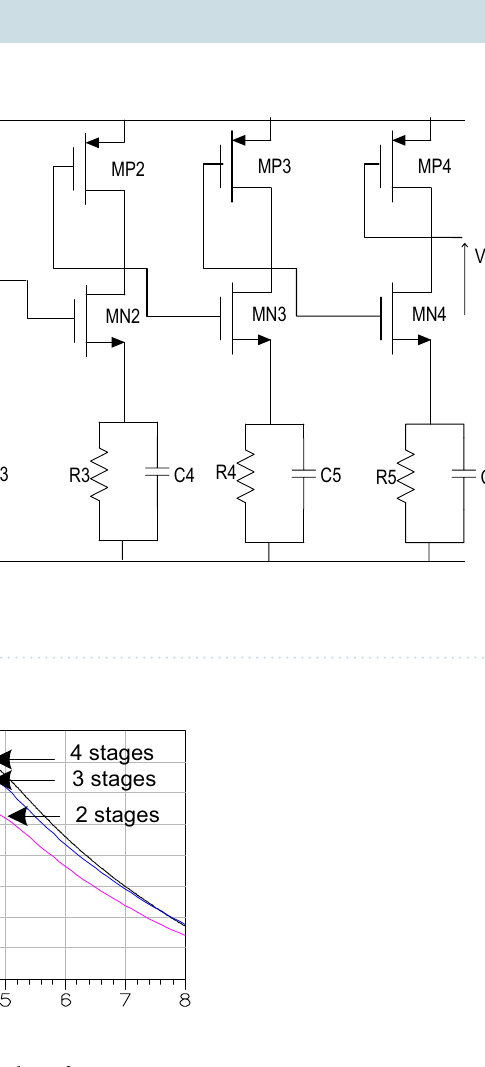
Figure 4. Gain comparison for different number of